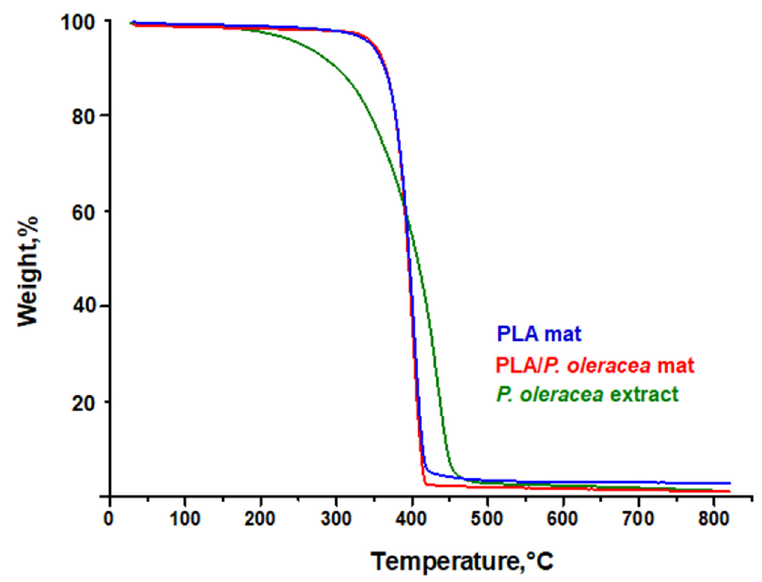
Figure 3. TG thermograms of crude P. oleracea extract, PLA, and PLA/ P. oleracea